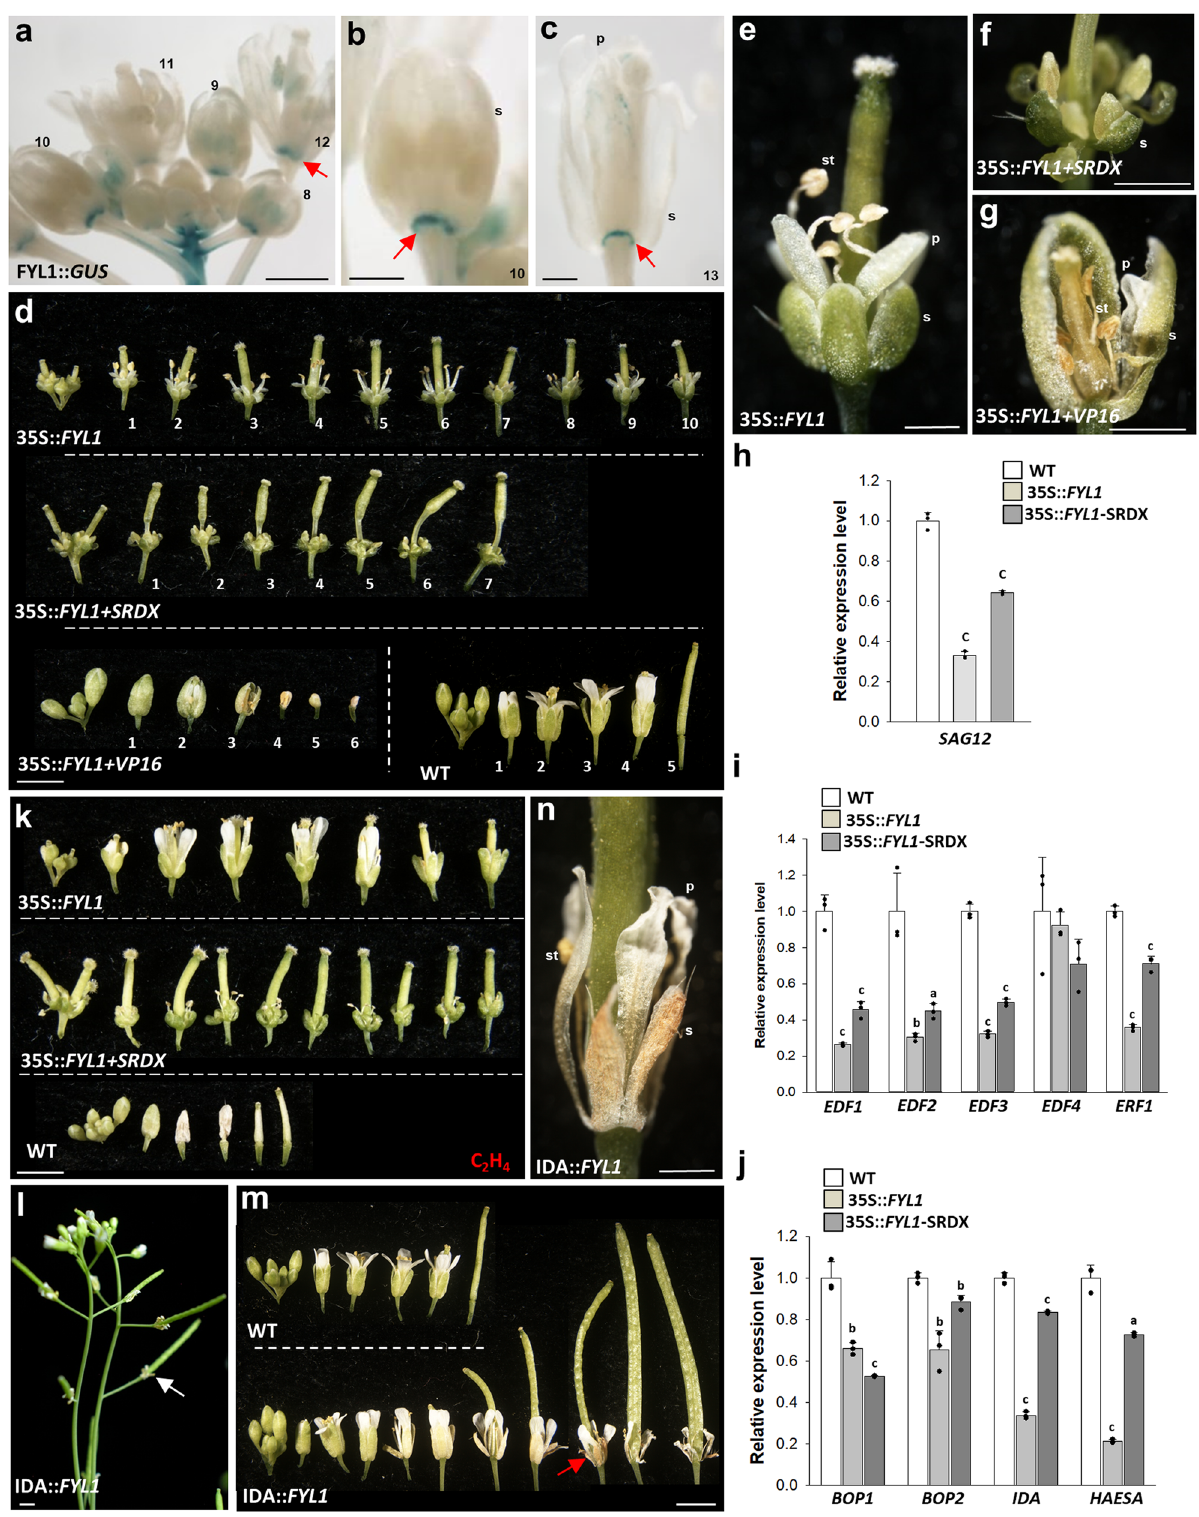
Arabidopsis were generated. 35S:: FYL2 plants surprisingly showed promotion of both fl ower senescence and abscission (Fig. 2e, fi rst row and 2f). A similar promotion of fl ower senescence/abscission was observed in 35S:: FYL2-DR + VP16 transgenic plants (Fig. 2e, third row and 2h), and an opposite delay of fl ower senescence/ abscission was produced in 35S:: FYL2 + SRDX transgenic plants (Fig. 2e, second row and 2g), suggesting that FYL2 should act as